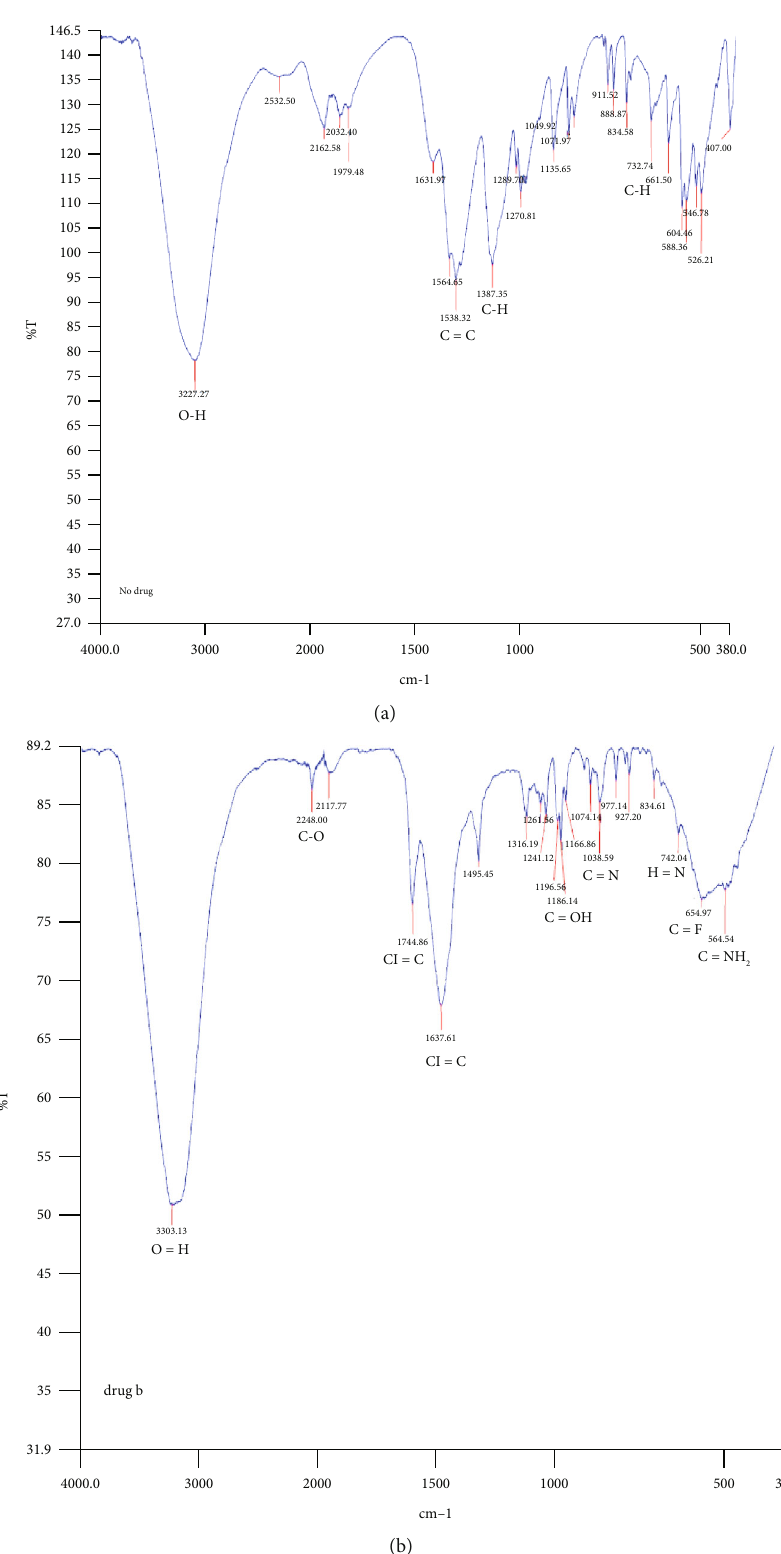
Figure 1: IR spectra of (a) AgNPs and (b) HAART (efavirenz, emtricitabine, and tenofovir disoproxil